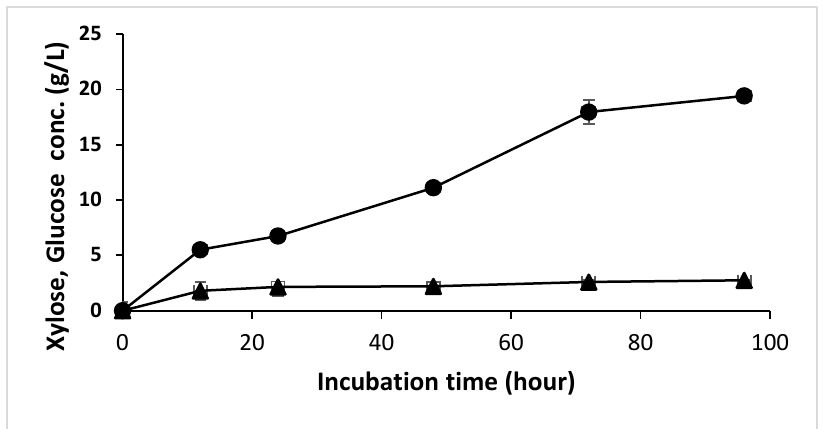
Figure 1. Xylose and glucose from OPEFB hydrolysis using xylanase. Xylose (solid circles), and glucose (solid triangles). Data presented are averages of triplicate experiments; error bars indicate the standard deviations.